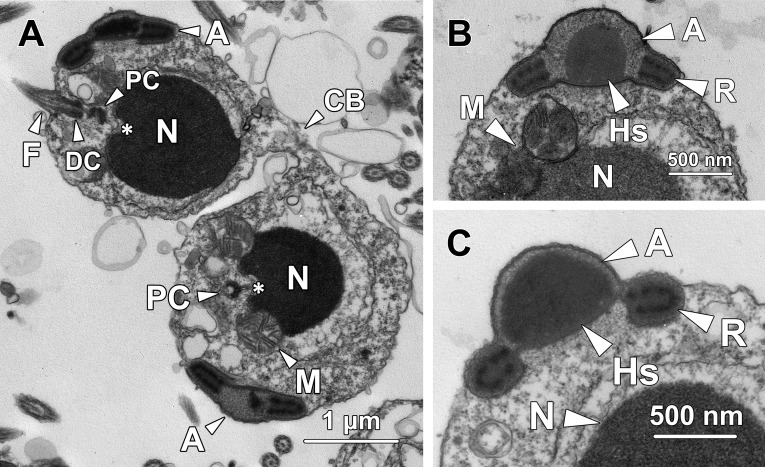
Transmission electron micrographs of step 8 spermatids.(A) Step 8 spermatids are still interconnected by a cytoplasmic bridge (CB). The nucleus (N) remains spherical in shape while the chromatin block transforms into an oval shape with a highly condensed homogeneous appearance. The proximal centriole (PC) extends its microtubules into the implantation fossa (*) and orientates perpendicularly to the flagellum (F) which originates from the distal centriole (DC). The developing acrosome (A) remains adjacent to the flagellum at this stage. (B) The central sphere firmly attaches to the posterior membrane of the acrosome (A) and transforms into a hemisphere (Hs). The ring-like structure (R), with darker particles lining its interior border, also comes into direct contact with the acrosomal membrane on both sides. The acrosomal matrix is filled with densely packed coarse granules. M, mitochondria; N, nucleus. (C) As the morphogenesis of the acrosome proceeds, the central hemisphere (Hs) increases its volume and ascends towards the anterior membrane, resulting in the formation of an indentation at the posterior end of the acrosome. N, nucleus; R, ring-shaped structure.